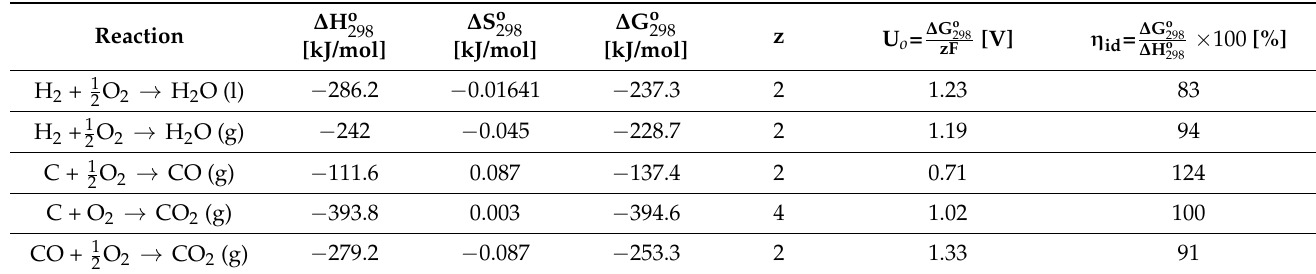
Table 5. Voltage and efficiency of chemical reactions [20].